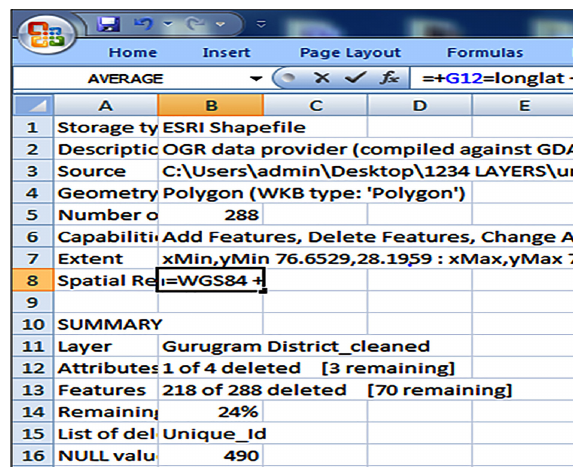
Fig. 15. Metadata and summary of cleaned